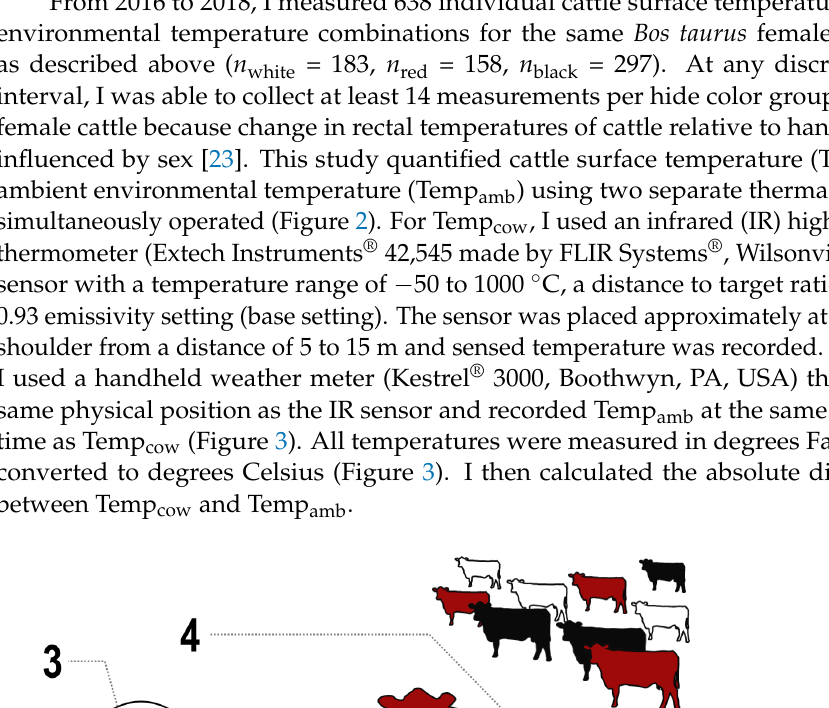
5 of 16 culated the relative albedo which is a cow:snow brightness ratio (Albedo rel ; Equation (4) [22]), Albedo rel = Bright cow ÷ Bright snow (4) where Bright cow is the mean brightness of specific cow hide pixels (i.e., black, red, or white cows) and Bright snow is the mean brightness of snow pixels which functions as ref- erence pixels. I then calculated absolute albedo for each cow color (Albedo abs ; Equation (5)), Albedo abs = Albedo rel × 0.85